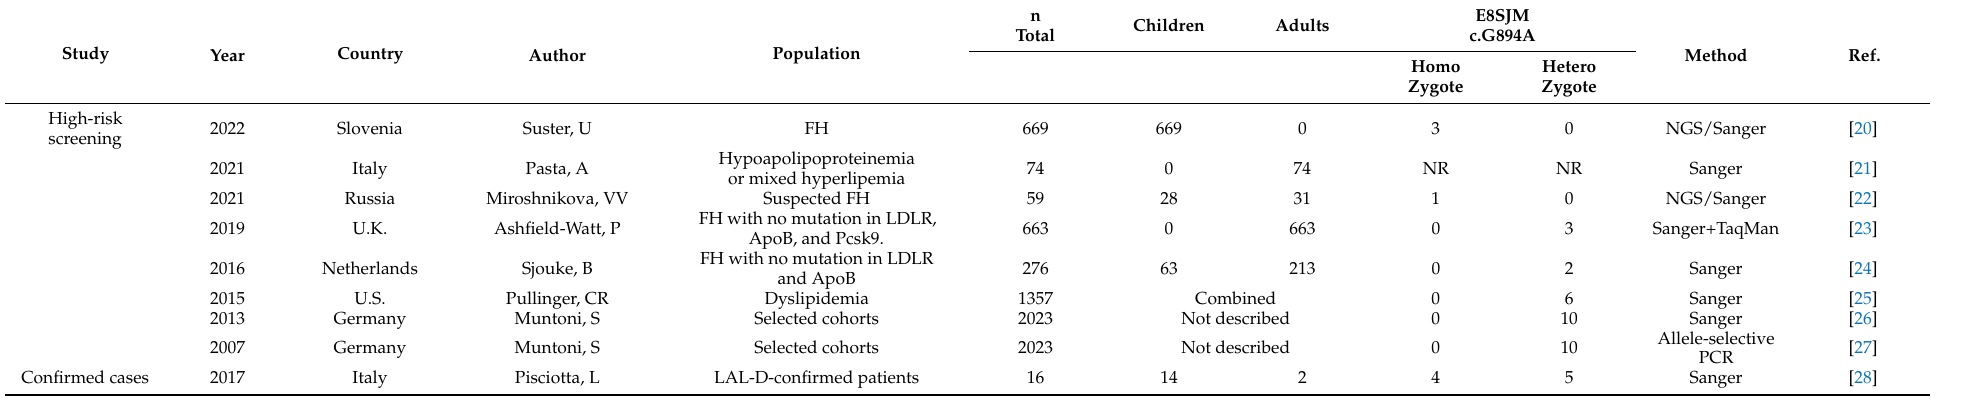
Table 1. The LIPA gene